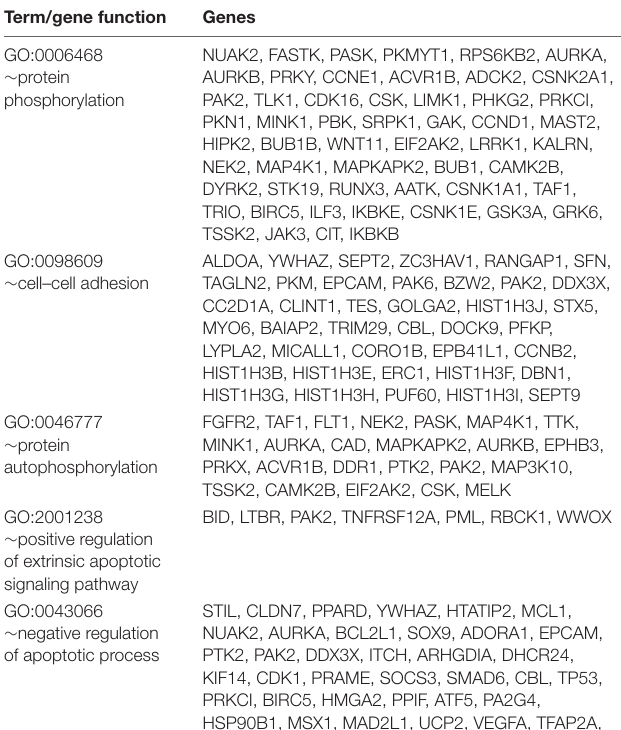
TABLE 5 | Gene ontology (GO) analysis of five typical pathways associated with ovarian cancer (OC). Term/gene